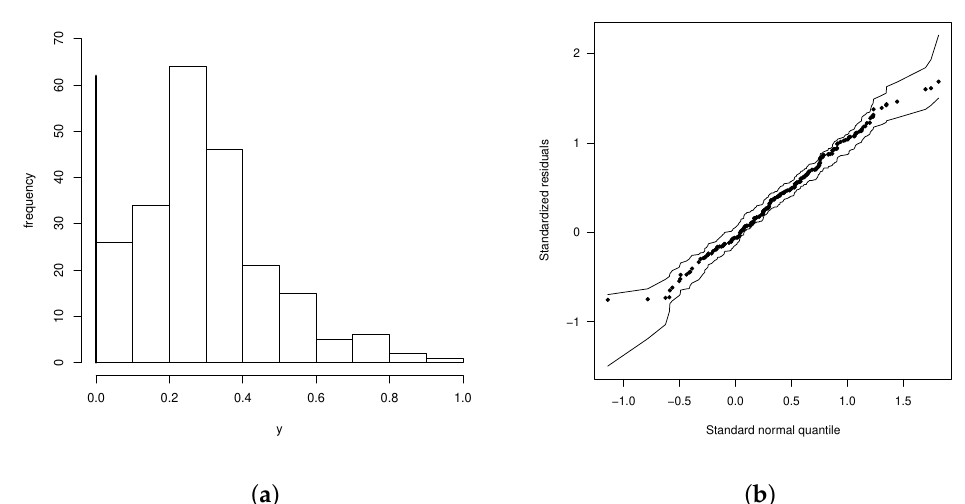
Figure 2. ( a ) Histogram for the variable Y and ( b ) envelope graphics for r MT